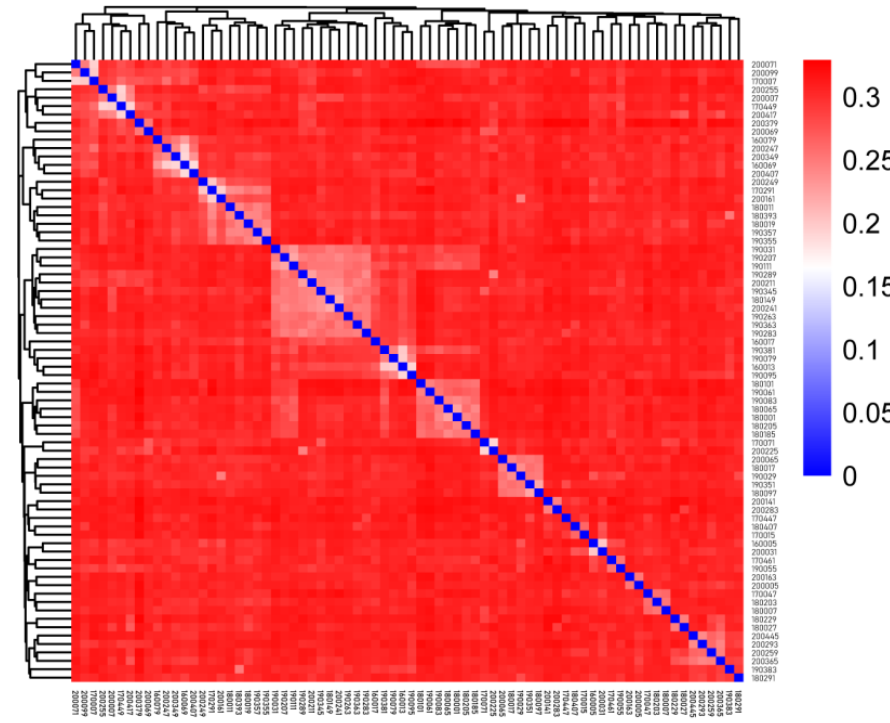
Figure 2. IBS distance matrix visualization in Tan sheep.